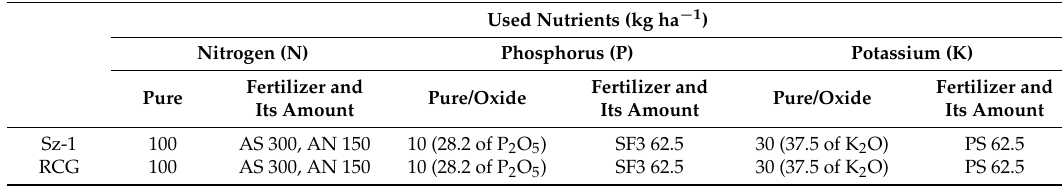
Table 4. Methodology of fertilization in productive